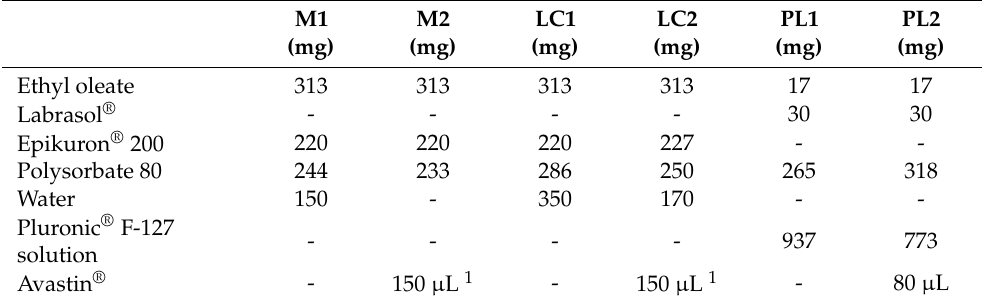
Table 3. Composition of the liquid systems formulated without BVZ or with BVZ as Avastin ® diluted with a